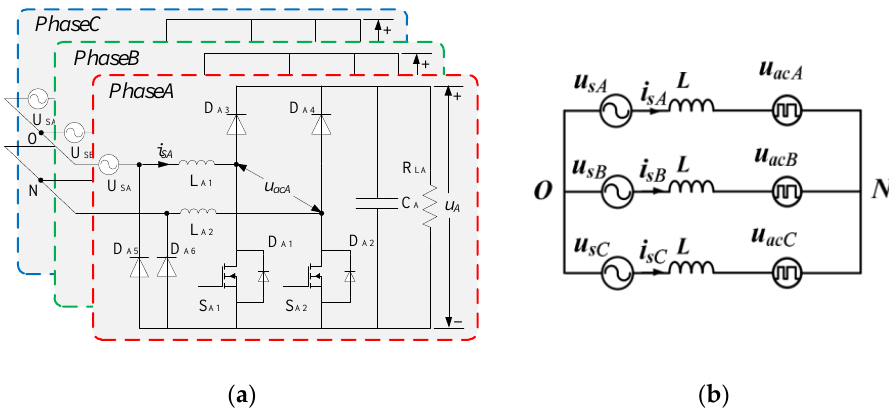
Figure 1. Three‐phase bridgeless converter topology and equivalent ac side circuit. ( a ) Circuit topology; ( b ) the equivalent ac side circuit.